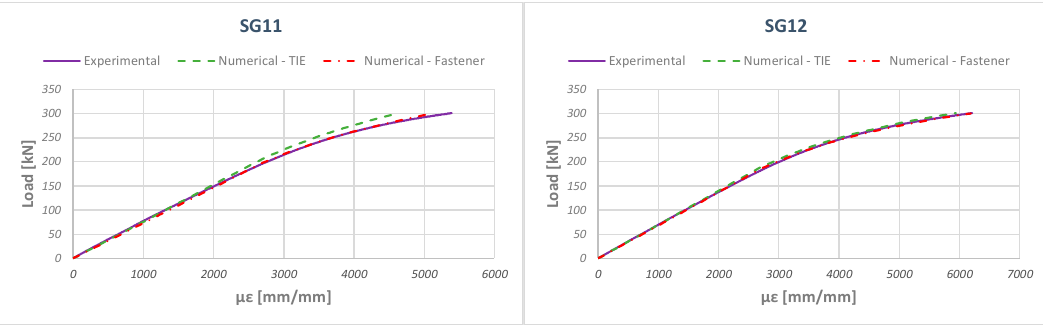
Figure 17. Numerical–experimental comparisons for SG-11 and SG-12: numerical TIE and Fasteners